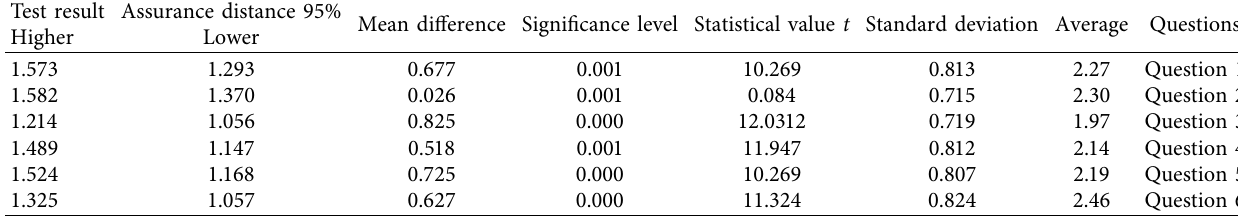
Table 2: Results of Student’s t test to investigate the effect of social resilience index on high urban crisis mortality.